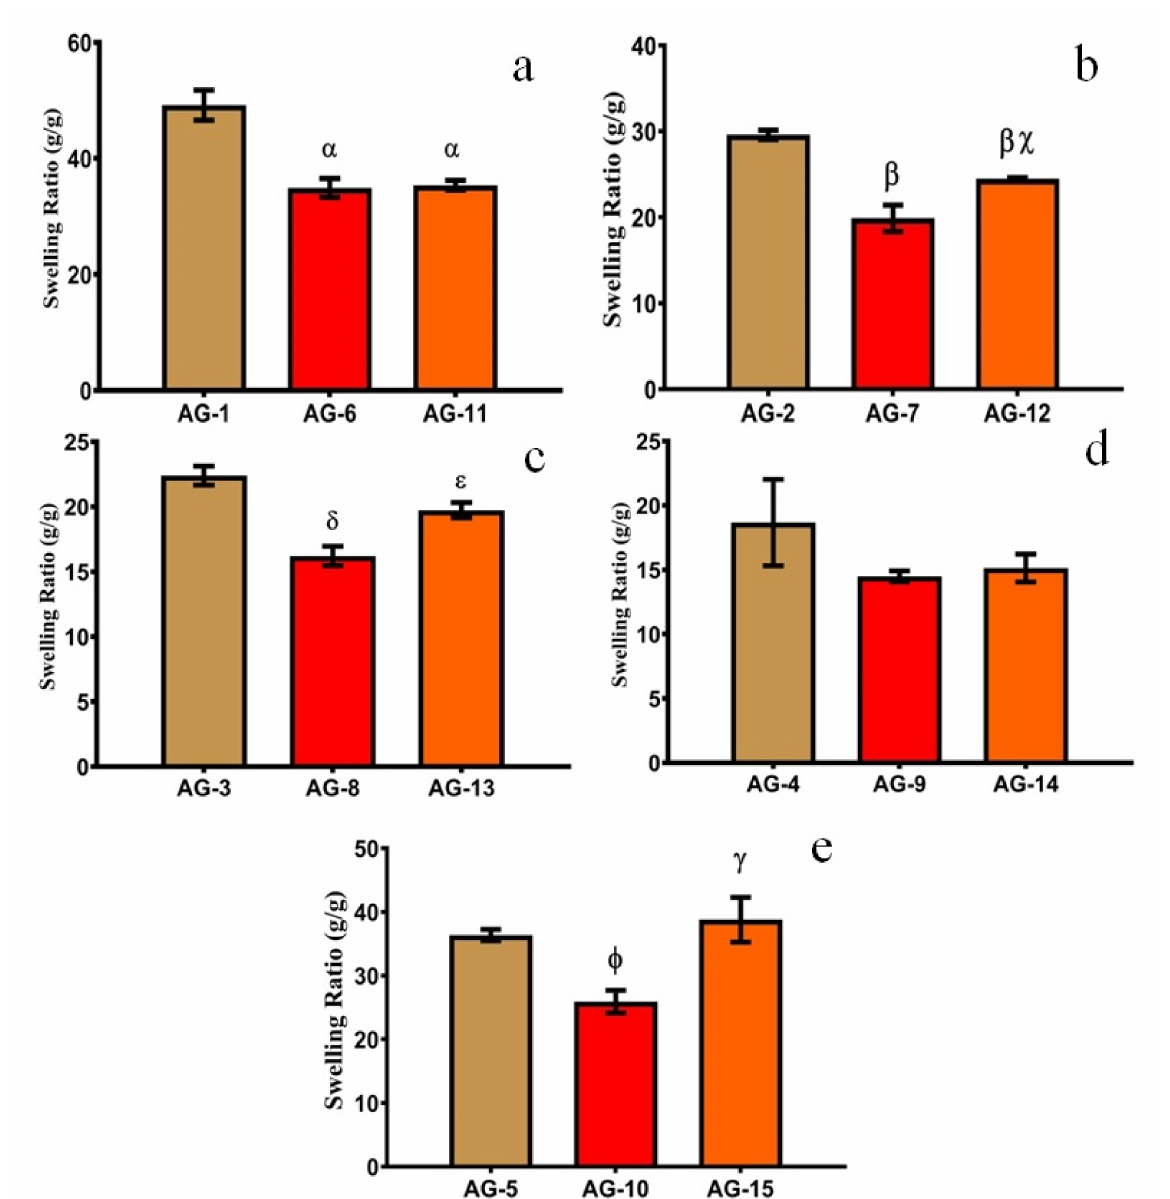
Figure 5. Effect of gelatin on equilibrium SR at pH 7.4 with different AA concentrations, i.e., ( a ) 16.66 g, ( b ) 33.33 g, ( c ) 50 g, ( d ) 66.66 g and ( e ) 83.33 g. Error bars presented as means ± SD ( n = 3). p < 0.05, α compared with AG-1, β compared with AG-2, χ compared with AG-7, δ compared with AG-3, ε compared with AG-8, φ compared with AG-5, γ compared with